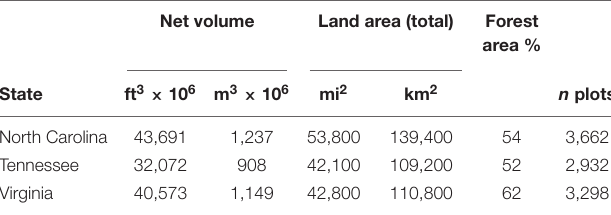
TABLE 1 | Forest volume and land area statistics for states in the study area, with the number of forested FIA sample plots ( n ) in each